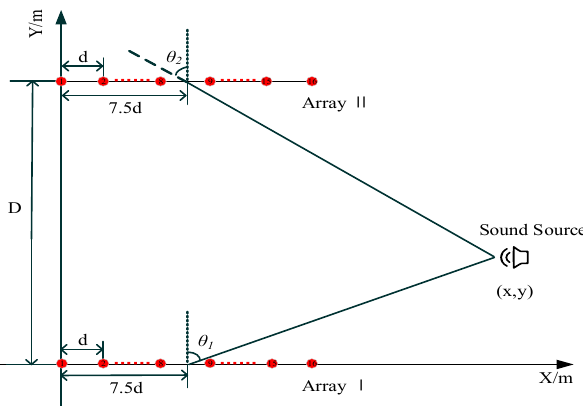
Figure 4. Sound source and microphone array simulation location.